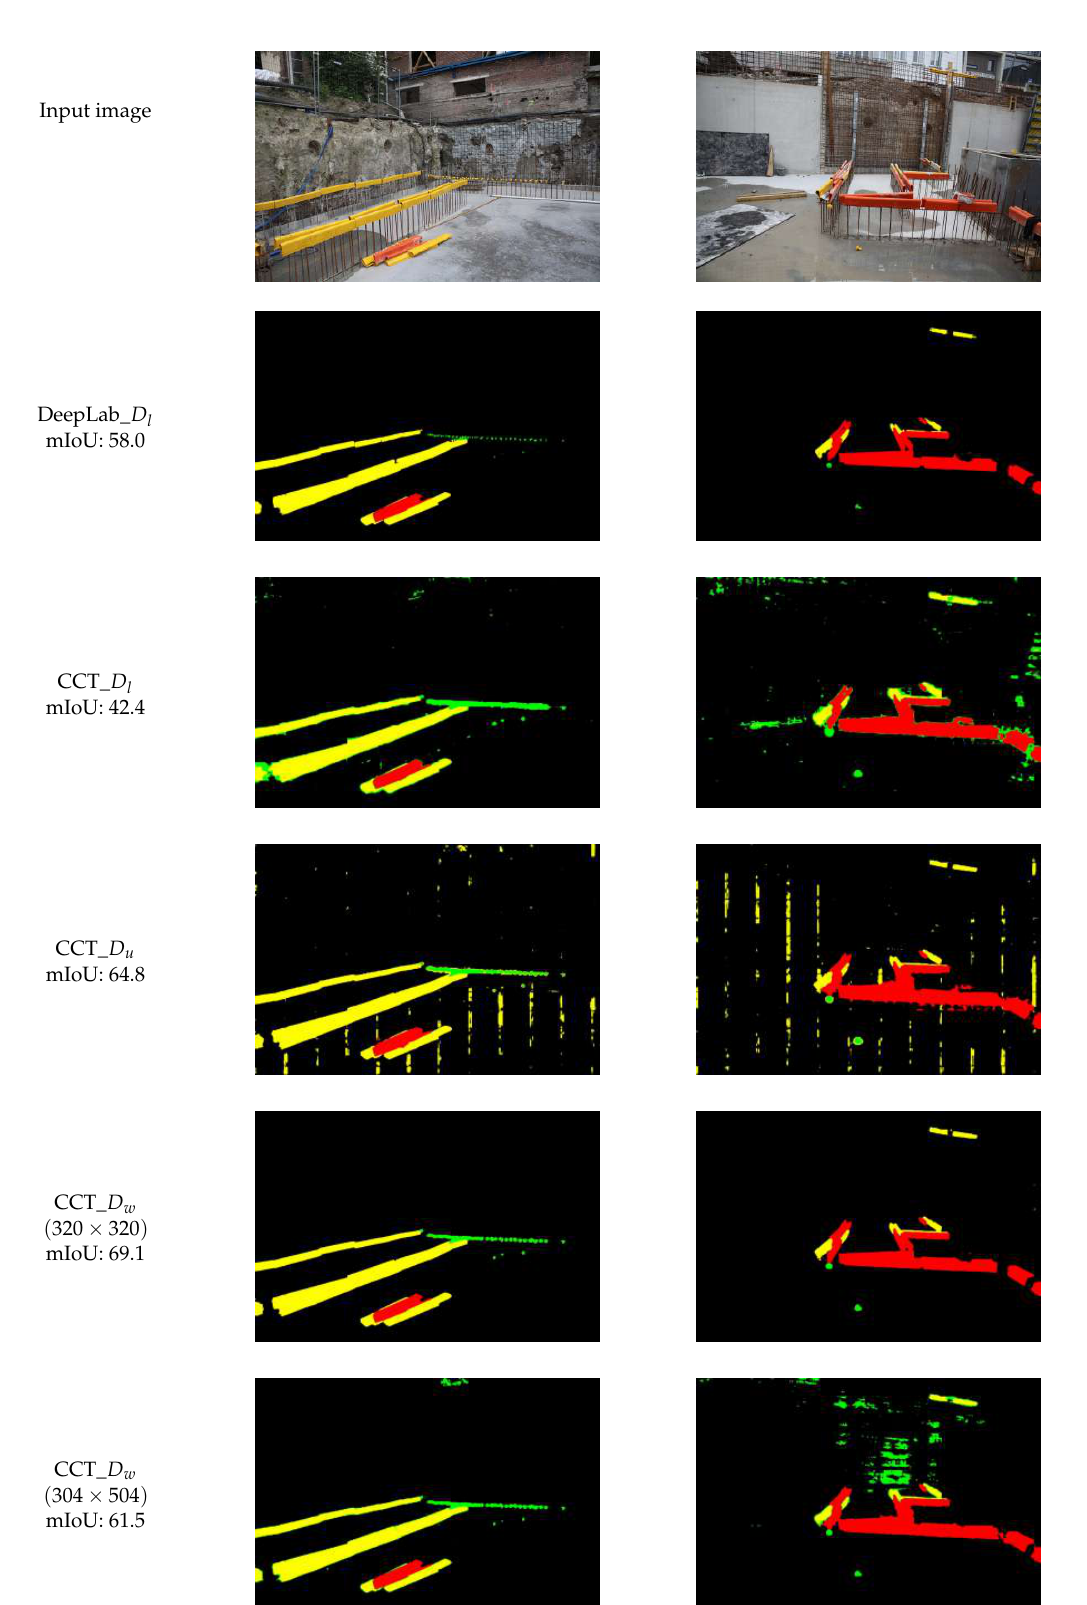
Figure 9. Results of trained CCT models and DeepLabv3+ on the D l dataset. Figure 10. Results of trained CCT models and DeepLabv3+ on the D l